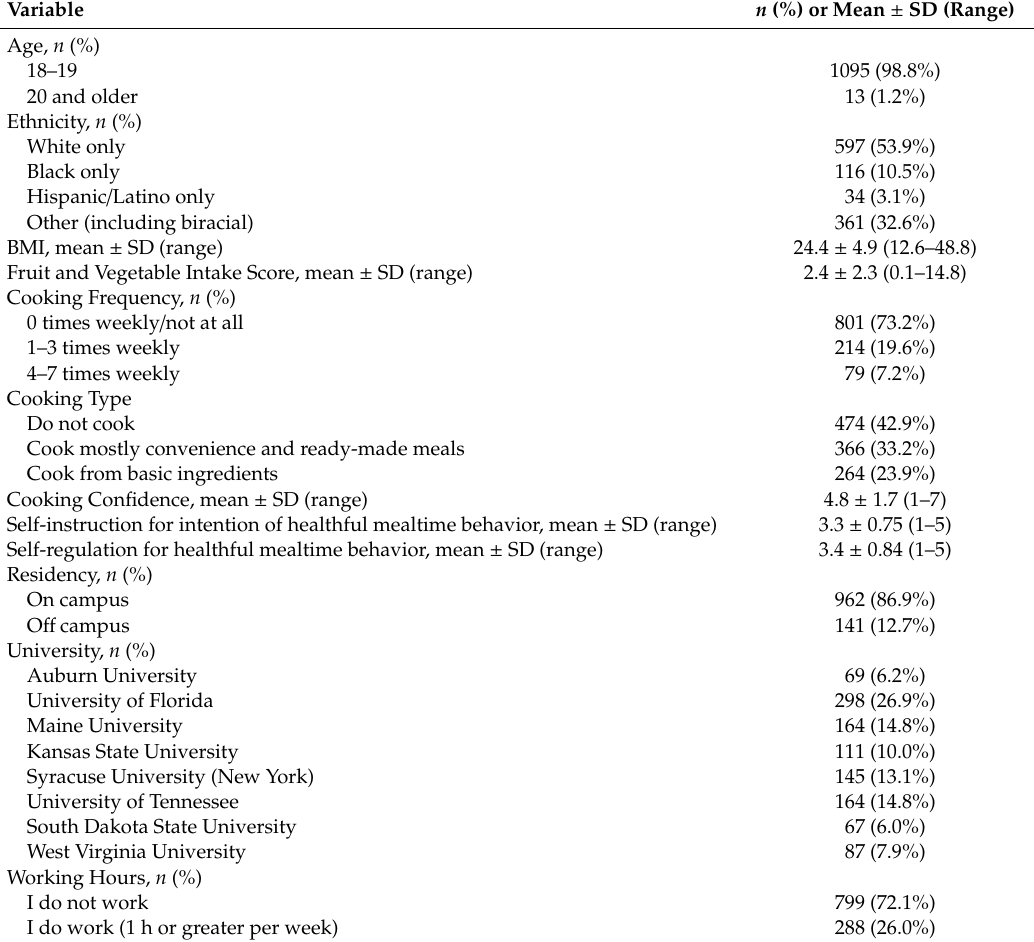
Table 1. Demographics of first-year college